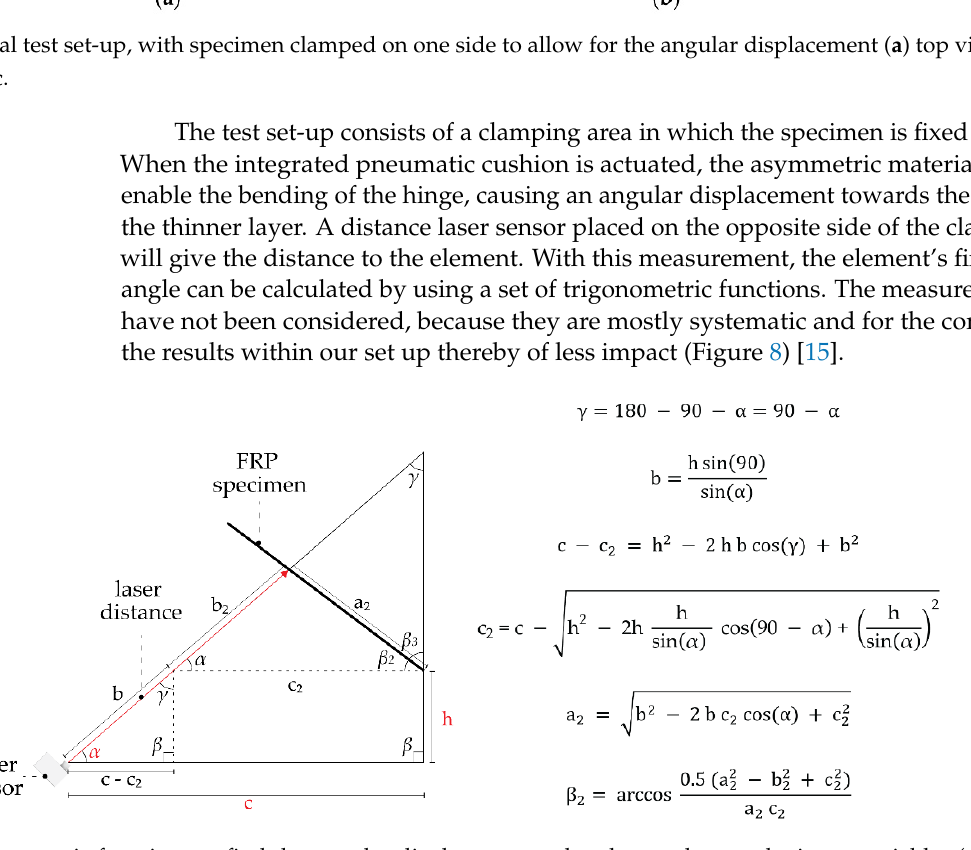
Figure 8. Trigonometric functions to find the angular displacement, when h, c and α are the input variables (adapted from [15]).